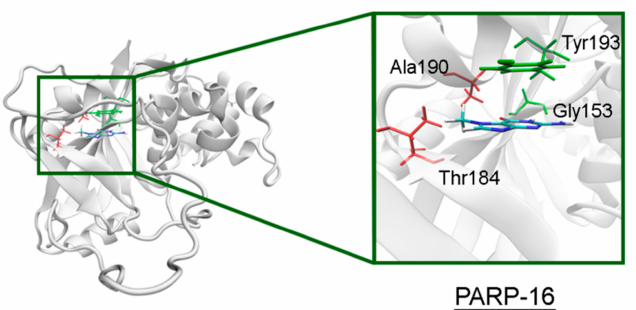
Figure 10. 7-MG position in the NA binding site of PARP-16 obtained using MD modeling. The conserved NA site residues are colored in green, and unique residues in red. The C γ atom of Thr184 forms a hydrophobic contact with the 7-MG methyl group.